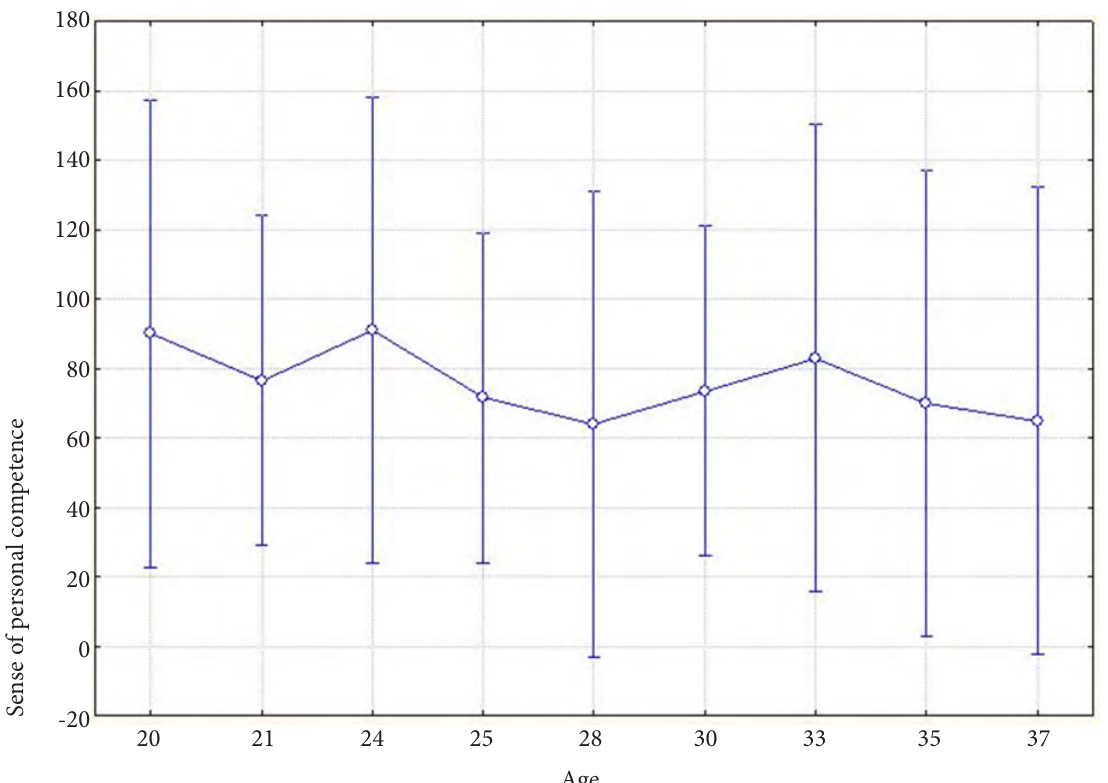
Figure 4. The diagram represents the result of analysis age and feeling of personal